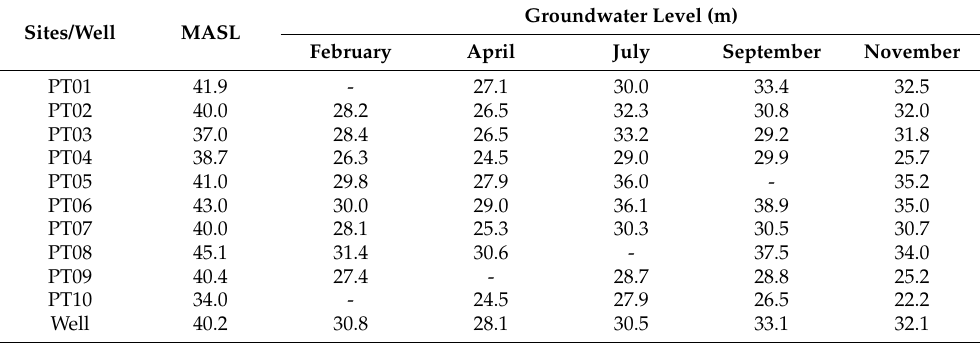
Table 3. The estimated Groundwater Level derived from Van Genchten (VG) for five different months of 2019. (MASL: Meters Above Sea Level).